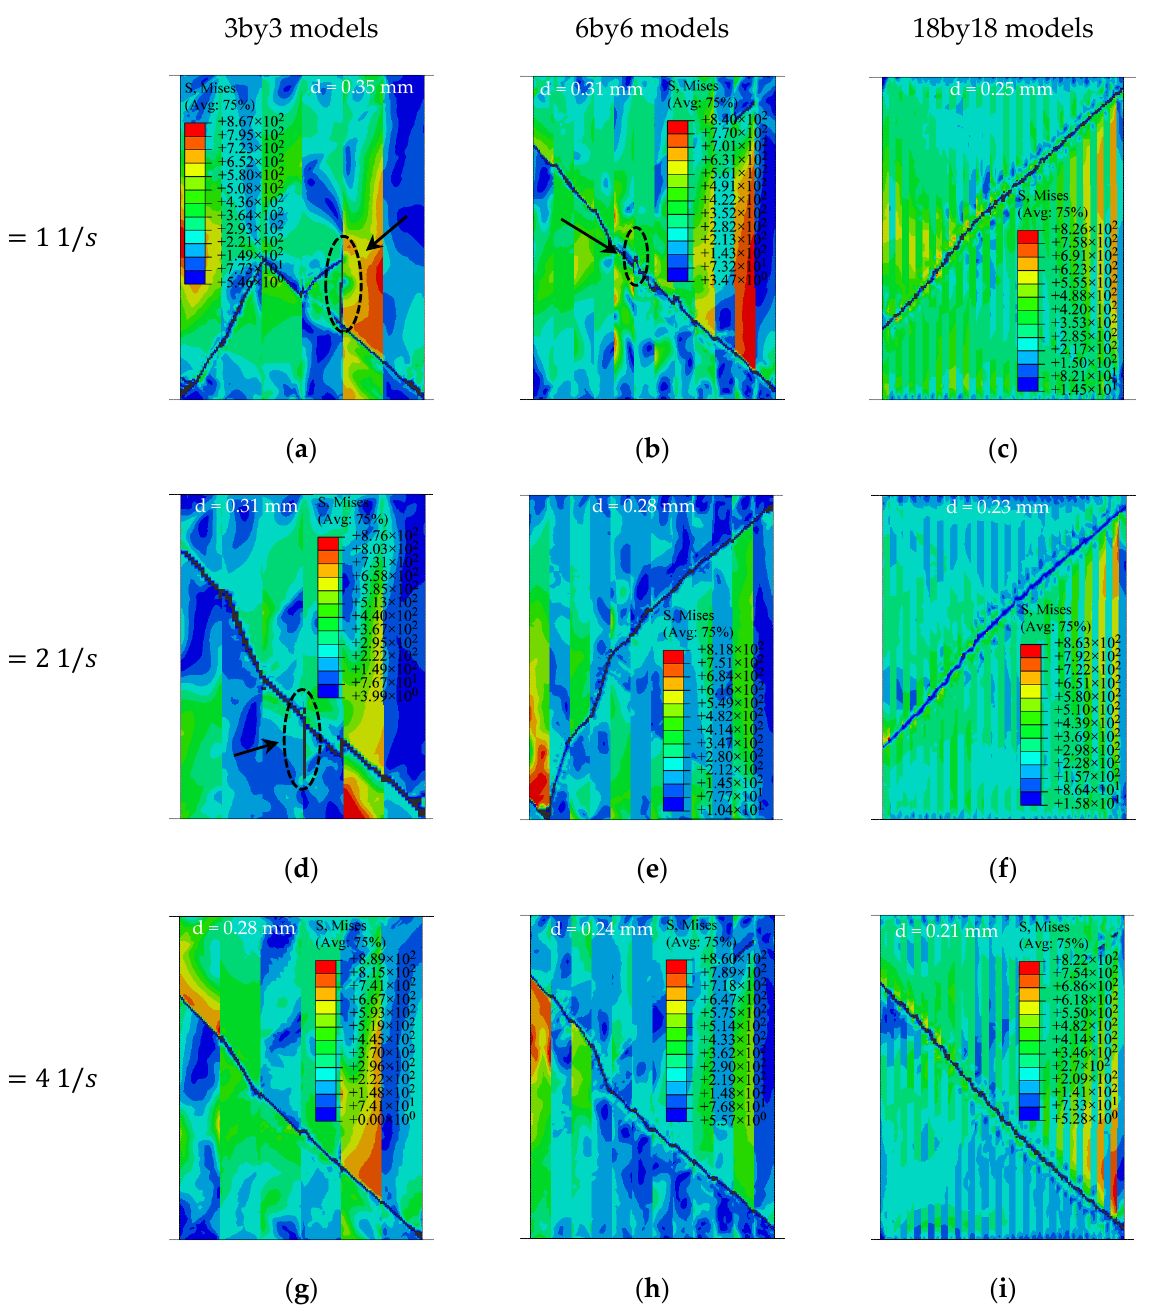
Figure 21. Redirection of fracture path and delamination-like behavior at the interfaces of ductile and brittle materials: ( a ) 3by3 at 𝜀(cid:4662) (cid:3036) = 1 s − 1 , ( b ) 6by6 at 𝜀(cid:4662) (cid:3036) = 1 s − 1 , ( c ) 18by18 at 𝜀(cid:4662) (cid:3036) = 1 s − 1 , ( d ) 3by3 at 𝜀(cid:4662) (cid:3036) = 2 s − 1 , ( e ) 6by6 at 𝜀(cid:4662) (cid:3036) = 2 s − 1 , ( f ) 18by18 𝜀(cid:4662) (cid:3036) = 2 s − 1 , ( g ) 3by3 at 𝜀(cid:4662) (cid:3036) = 4 s − 1 , ( h ) 6by6 at 𝜀(cid:4662) (cid:3036) = 4 s − 1 and ( i ) 18by18 at 𝜀(cid:4662) (cid:3036) = 4 s − 1 . The stroke, d , is shown at the top of the models.